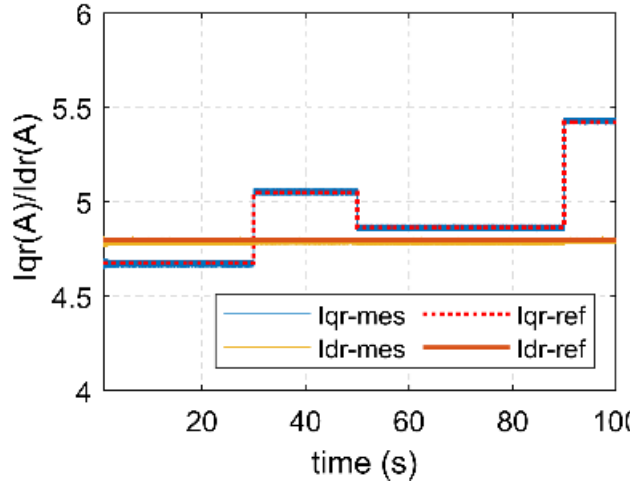
Figure 6. Direct and quadrature rotor current.